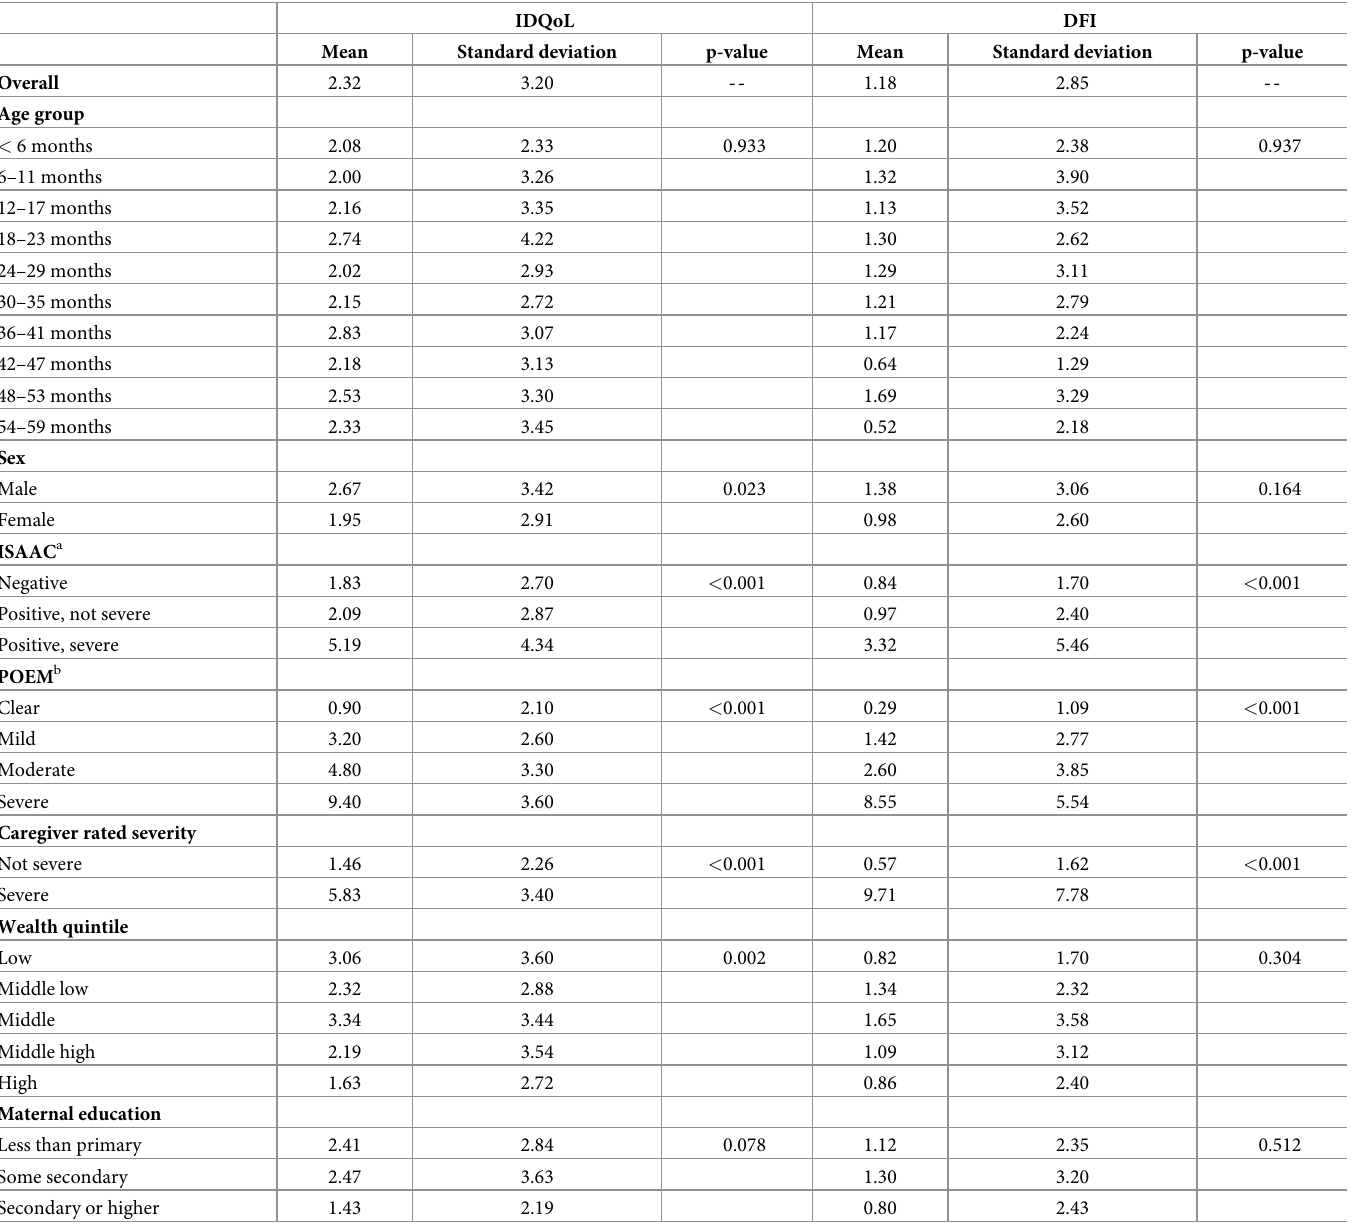
Table 5. Infants’ Dermatitis Quality of Life (IDQoL) and Dermatitis Family Impact (DFI) scores. IDQoL DFI Mean Standard deviation